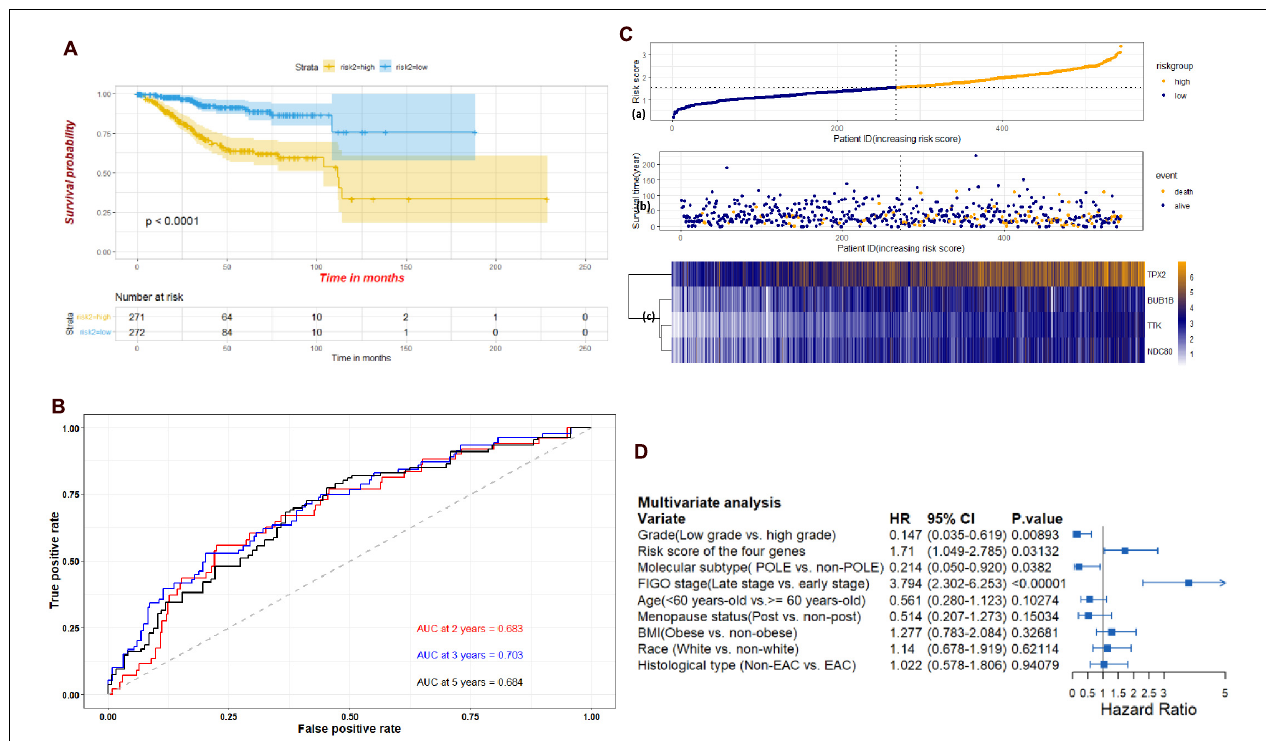
FIGURE 9 | (A) Kaplan-Meier plots of the UCEC dataset stratified by high-risk and low-risk groups based on median risk score of the four genes. (B) Time-dependent ROC plot risk scores of the four hub genes. (C) The risk score performance of the four hub genes in the UCEC dataset. (D) Multivariate analysis of clinical factors in the UCEC